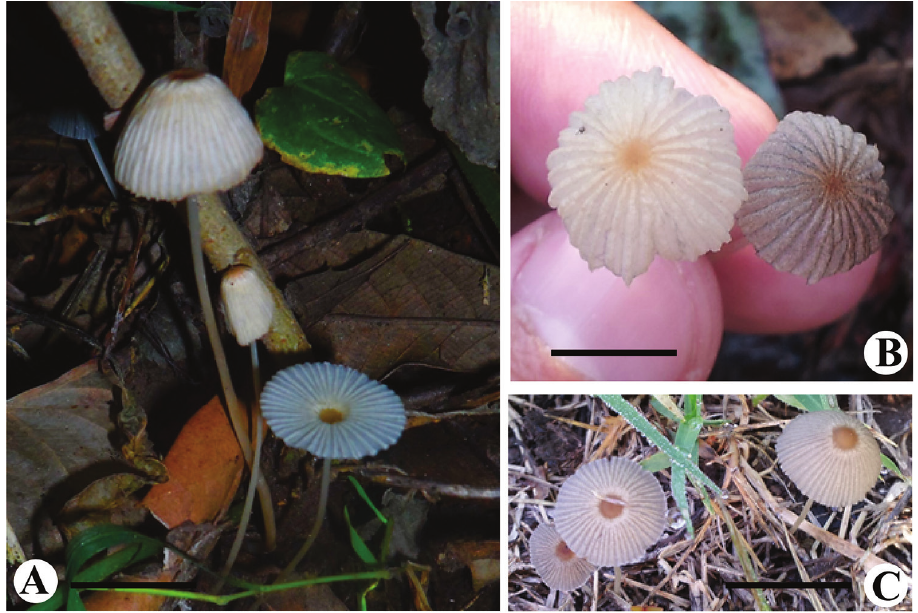
Figure 6. Basidiomata of Parasola pseudolactea sp. nov. P. auricoma and P. lilatincta . A Parasola pseudo- lactea sp. nov. collection SU-412 (HOLOTYPE HUP SU-412) B Parasola lilatincta collection SHP-8 (HUP-SHP-8) C Parasola auricoma collection SHP7 (LAH-SHP-7). Scale bars: 20